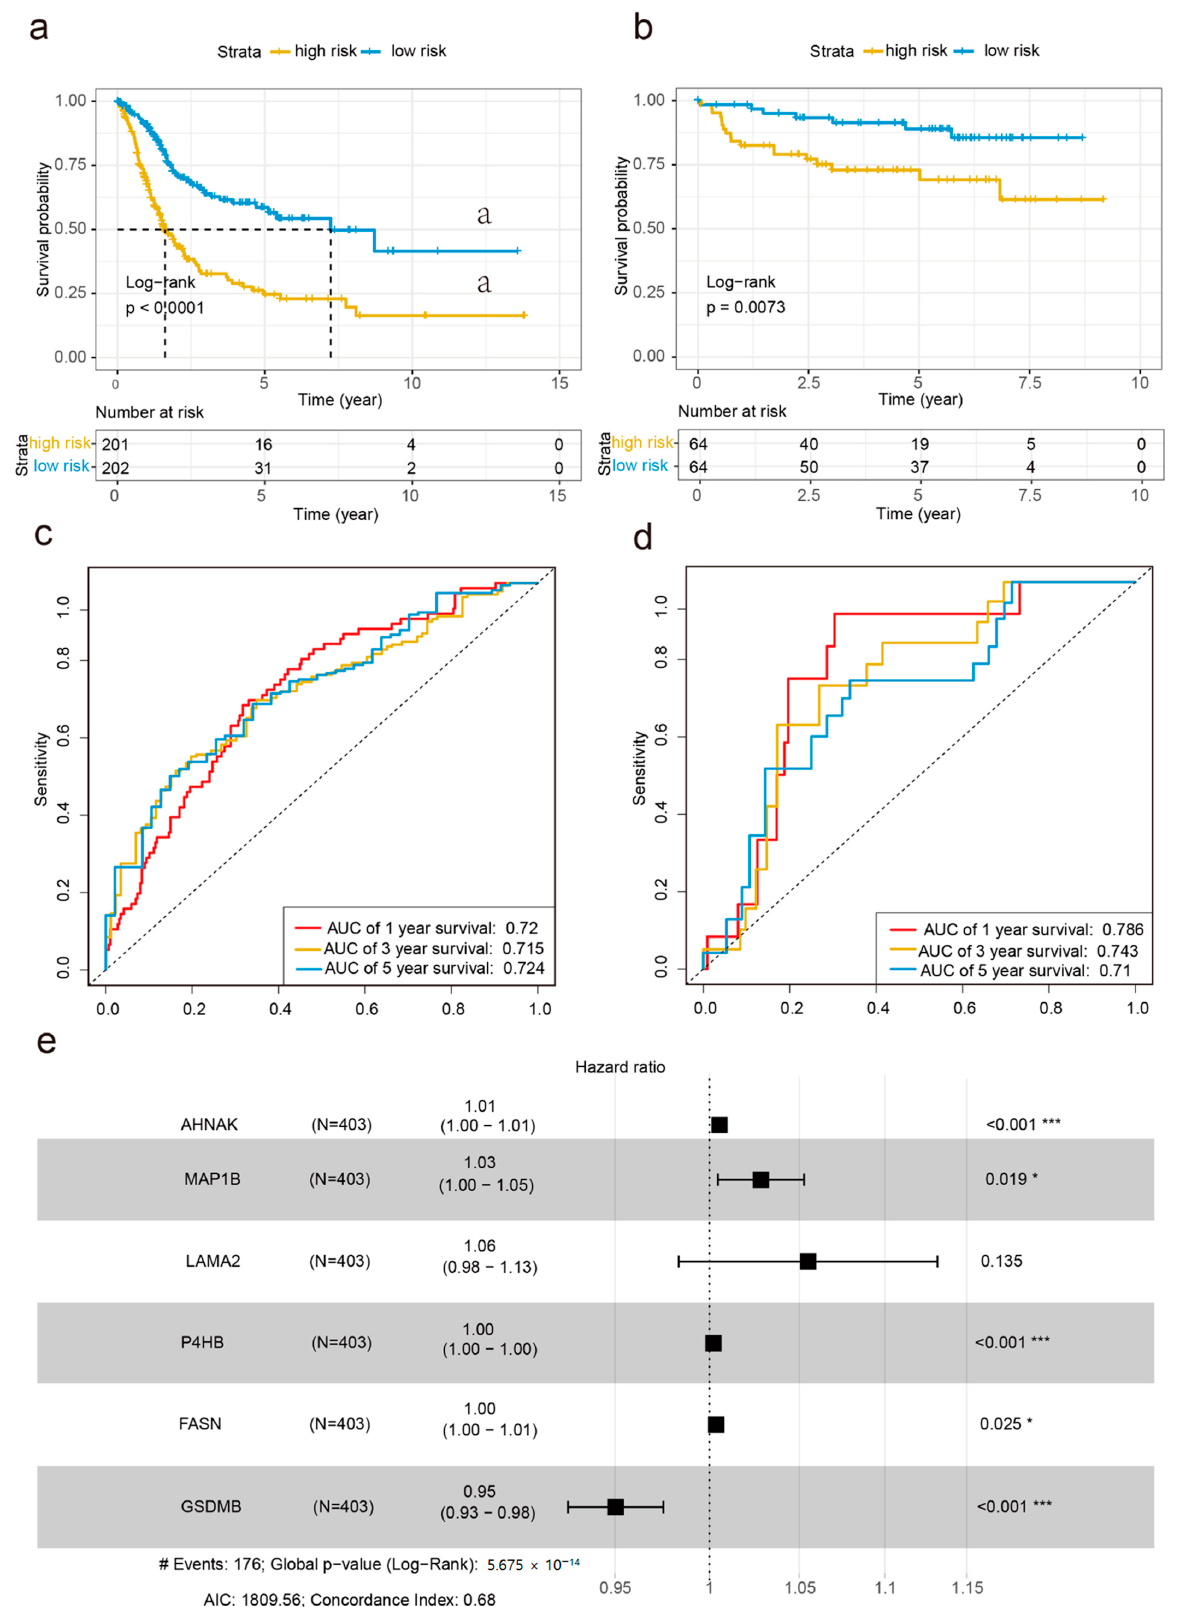
Figure 2. DEGs (differentially expressed genes) of RBPs were utilized to build prognostic models and analyze and verify GEO datasets. ( a ) Survival analysis of the training cohort. ( b ) The